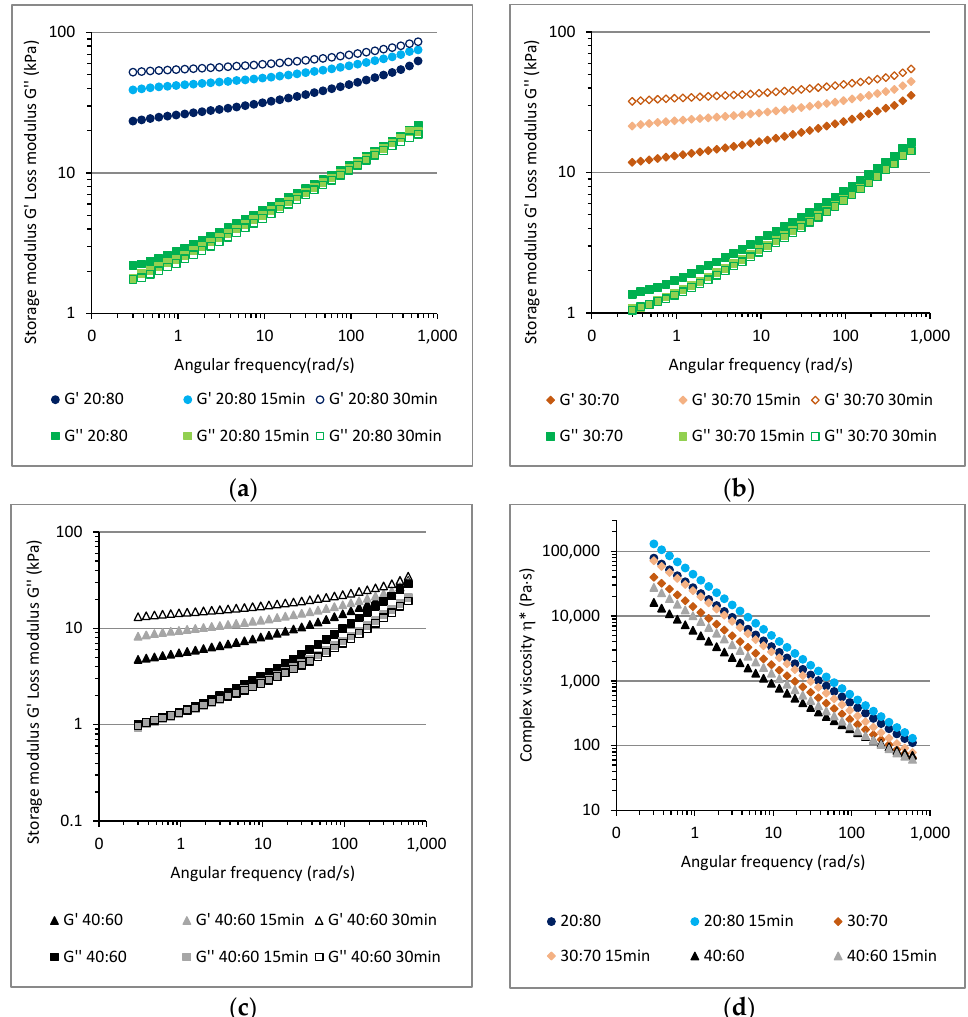
Figure 2. Influence of thermal treatment during 15 and 30 min of compression molding at 160 °C on the viscoelastic properties of molten PLA/ENR formulations, the storage modulus G’, loss modulus G’’ for: 20:80 PLA/ENR ( a ); 30:70 PLA/ENR ( b ); 40:60 PLA/ENR ( c ); and complex viscosity η * of PLA/ENR blends ( d ).